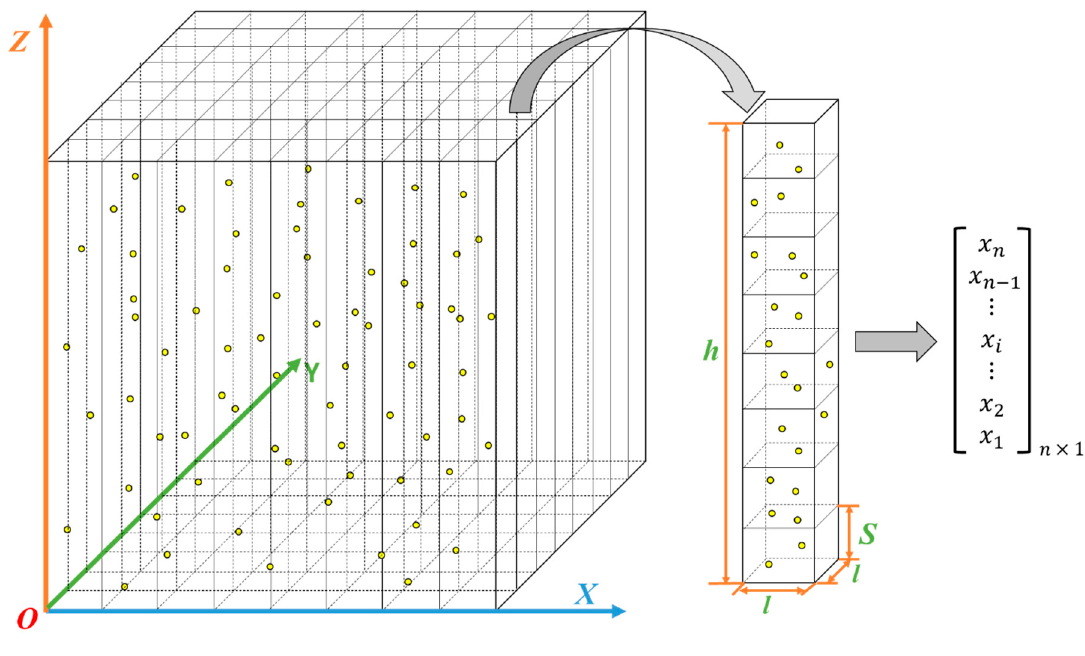
Figure 6. The process of setting cubic square grids for points, stratifying each grid into layers, and constructing vectors for grids.